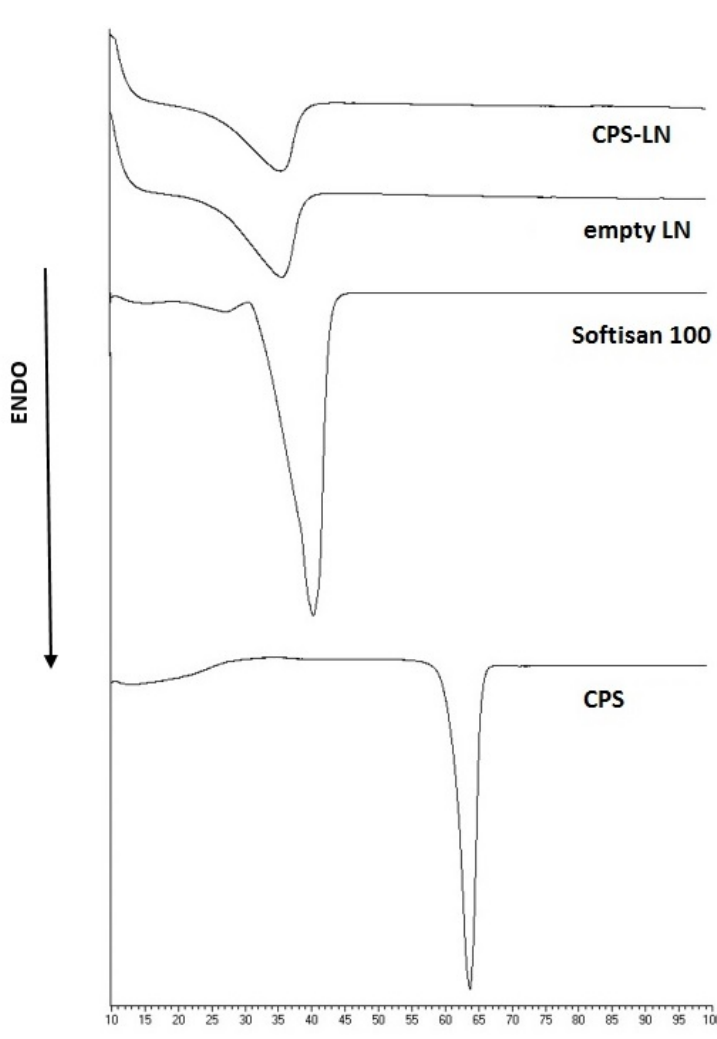
Figure 2. Di ff erential Scanning Calorimetry (DSC) thermogram scans of components, unloaded Figure 2. Differential Scanning Calorimetry (DSC) thermogram scans of components, unloaded and and CPS-LN.